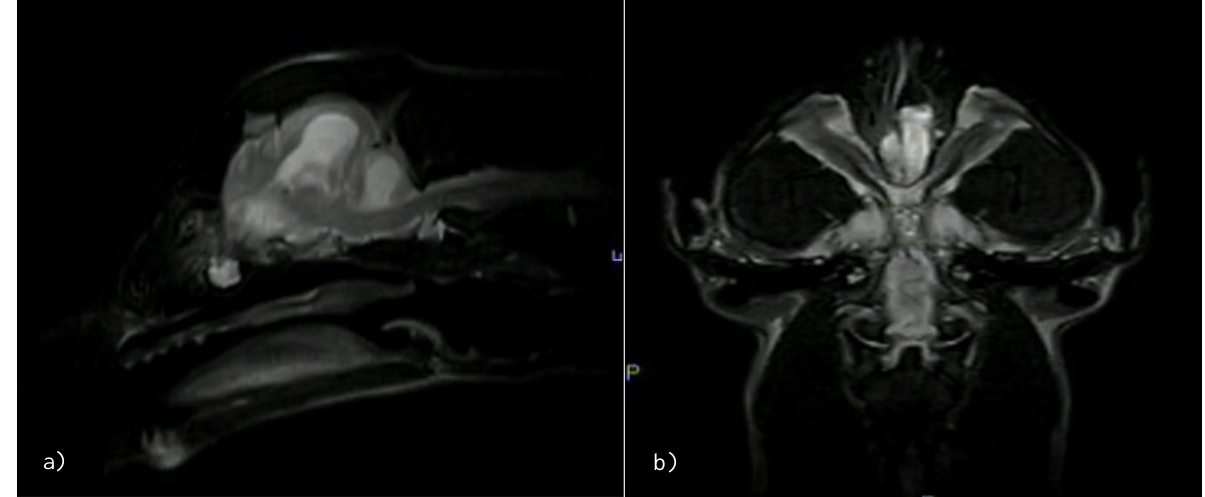
Fig. 3. Magnetic resonance imaging of the dog with post-traumatic changes in the brain (24 hours after injury) Note : a, b – sagittal and coronary sections at the level of olfactory bulb granuloma in T2 mode (MRI 0.3T).